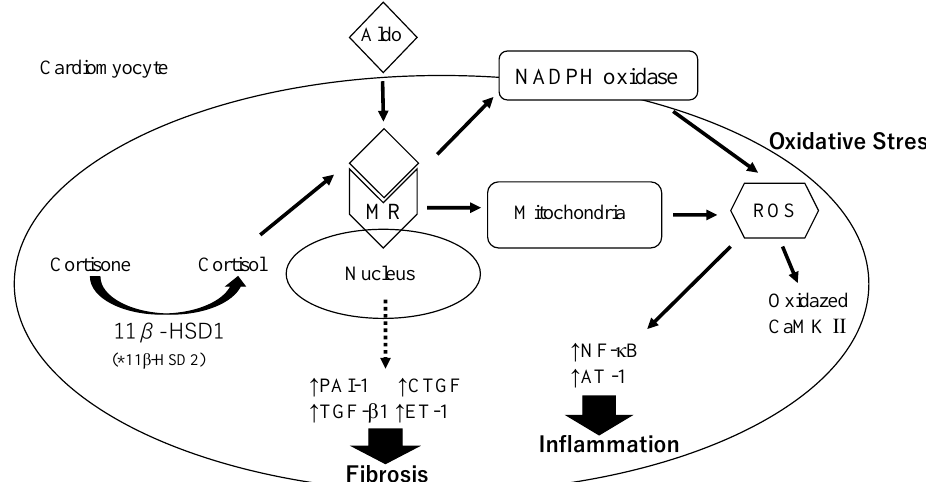
Figure 1. The mechanism underlying oxidative stress, inflammation, and fibrosis through the genomic pathway by aldosterone. * In the renal nephron and colon, 11 β -HSD2 converts cortisol to the inactive form of 11-ketometaabolite; therefore, cortisol is not associated with genomic pathological effects of aldosterone in the kidney.